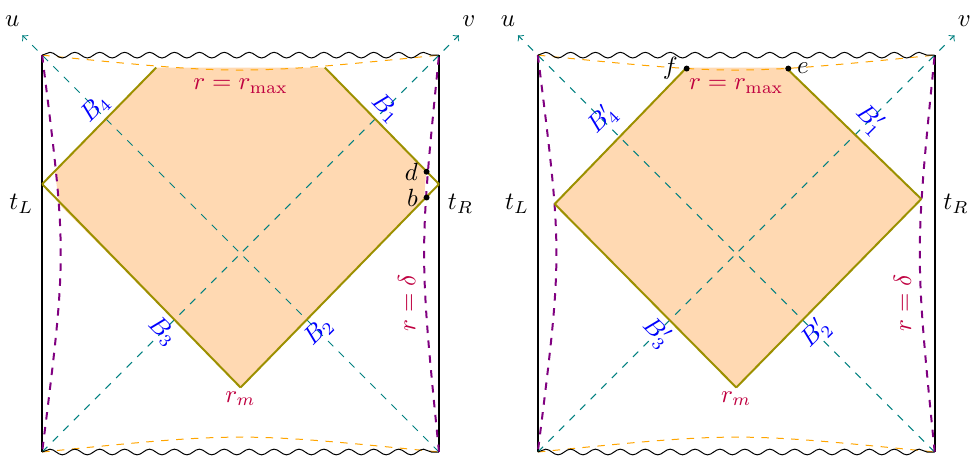
Figure 1 . WDW patches for an eternal two-sided black hole in two di(cid:11)erent regularizations: Left) the (cid:12)rst regularization in which we cut the WDW patch at the radius r = (cid:14) . Right) the second regularization in which we cut the spacetime at the radius r = (cid:14)